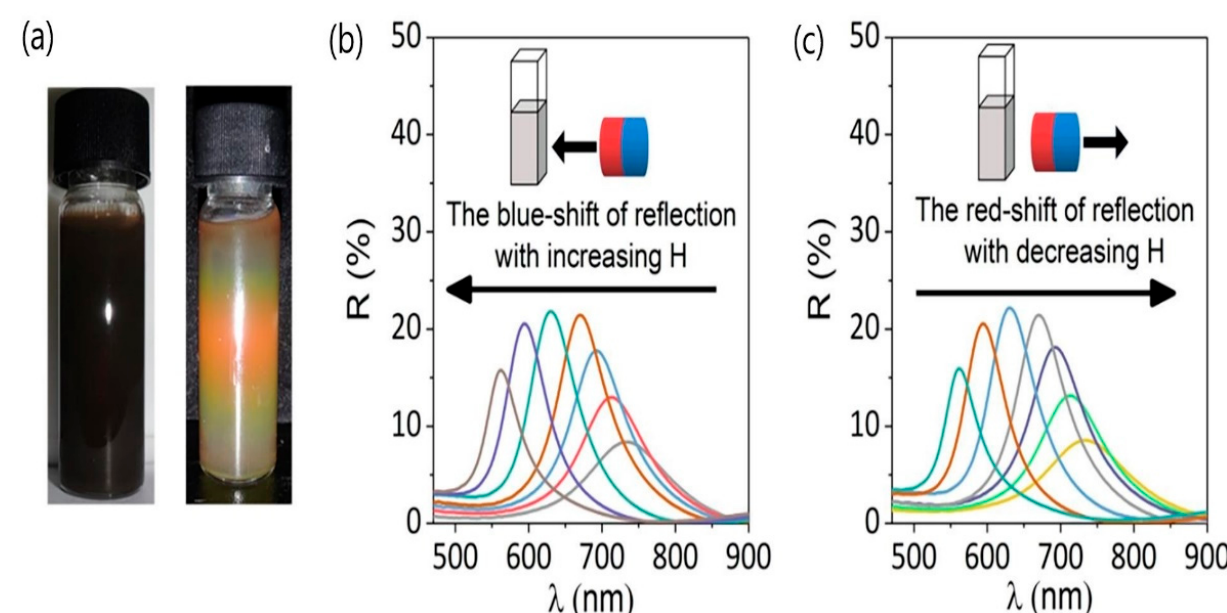
Figure 11. Reversible optical responses of a 100 nm Fe 3 O 4 colloid under increasing or decreasing external magnetic field (H): ( a ) digital photos of the Fe 3 O 4 colloid without H (left) and with H (right); ( b ) blue shift in the reflection when H is enhanced; and ( c ) red shift in the reflection when H is weakened (adopted from [100] with permission from Elsevier, 2019).